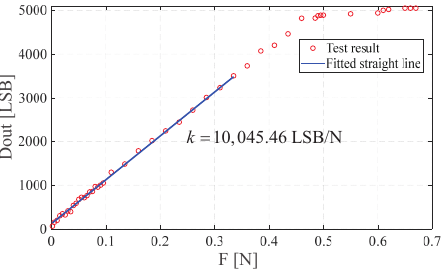
Figure 15. Test results of the tactile sensor response to force.